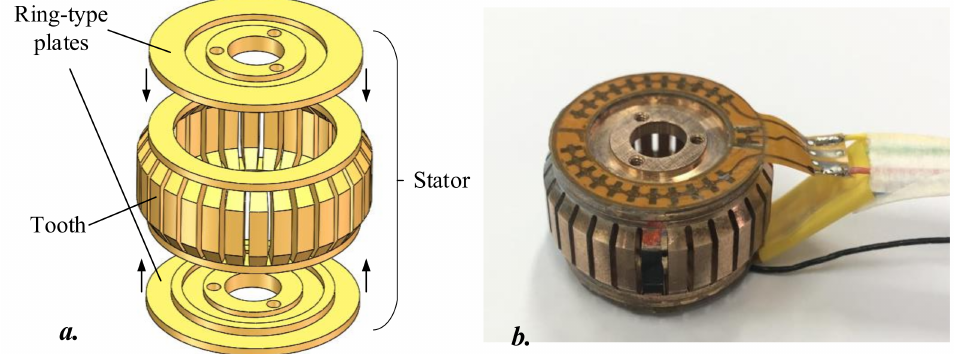
Figure 1. Proposed stator: ( a ) explosion view; ( b ) prototype.